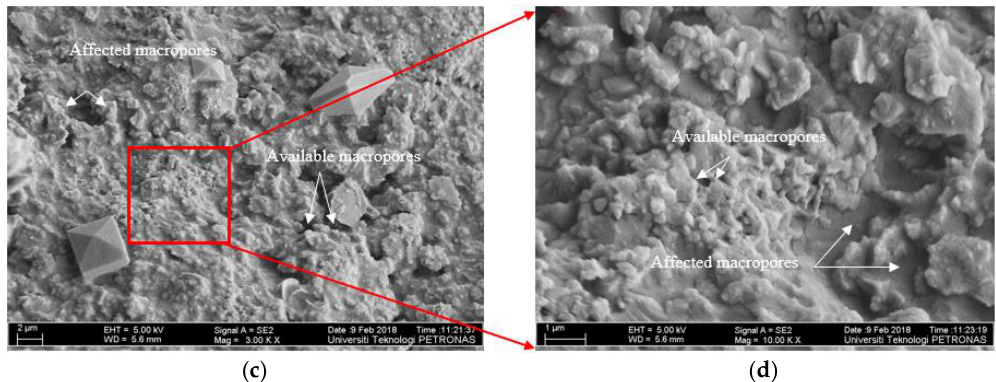
Figure 7. FE-SEM images of the KH shale sample. ( a ) KH untreated sample at 5K magnification shows several macropores clays and quartz; ( b ) KH untreated sample at 10K magnification shows interparticle macropores and confirms the presence of kspar, quartz, and clay; ( c ) KH treated sample by water immersion for two days at 3K magnification shows the water block effect on the pores and physical properties in the changes of shales, only a few macropores remained unblocked; ( d ) KH treated sample under water immersion at 10K magnification showed totally blocked macropores and only a few remained unblocked.